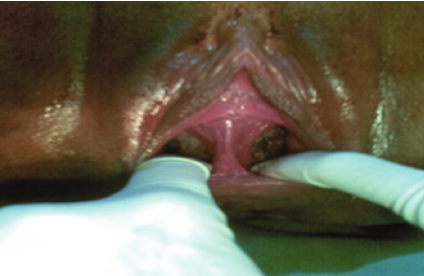
Figure 1: Longitudinal vaginal septum detected during delivery.